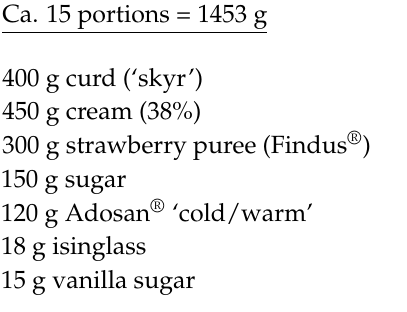
the wanted fluidity. Add salt and pepper for